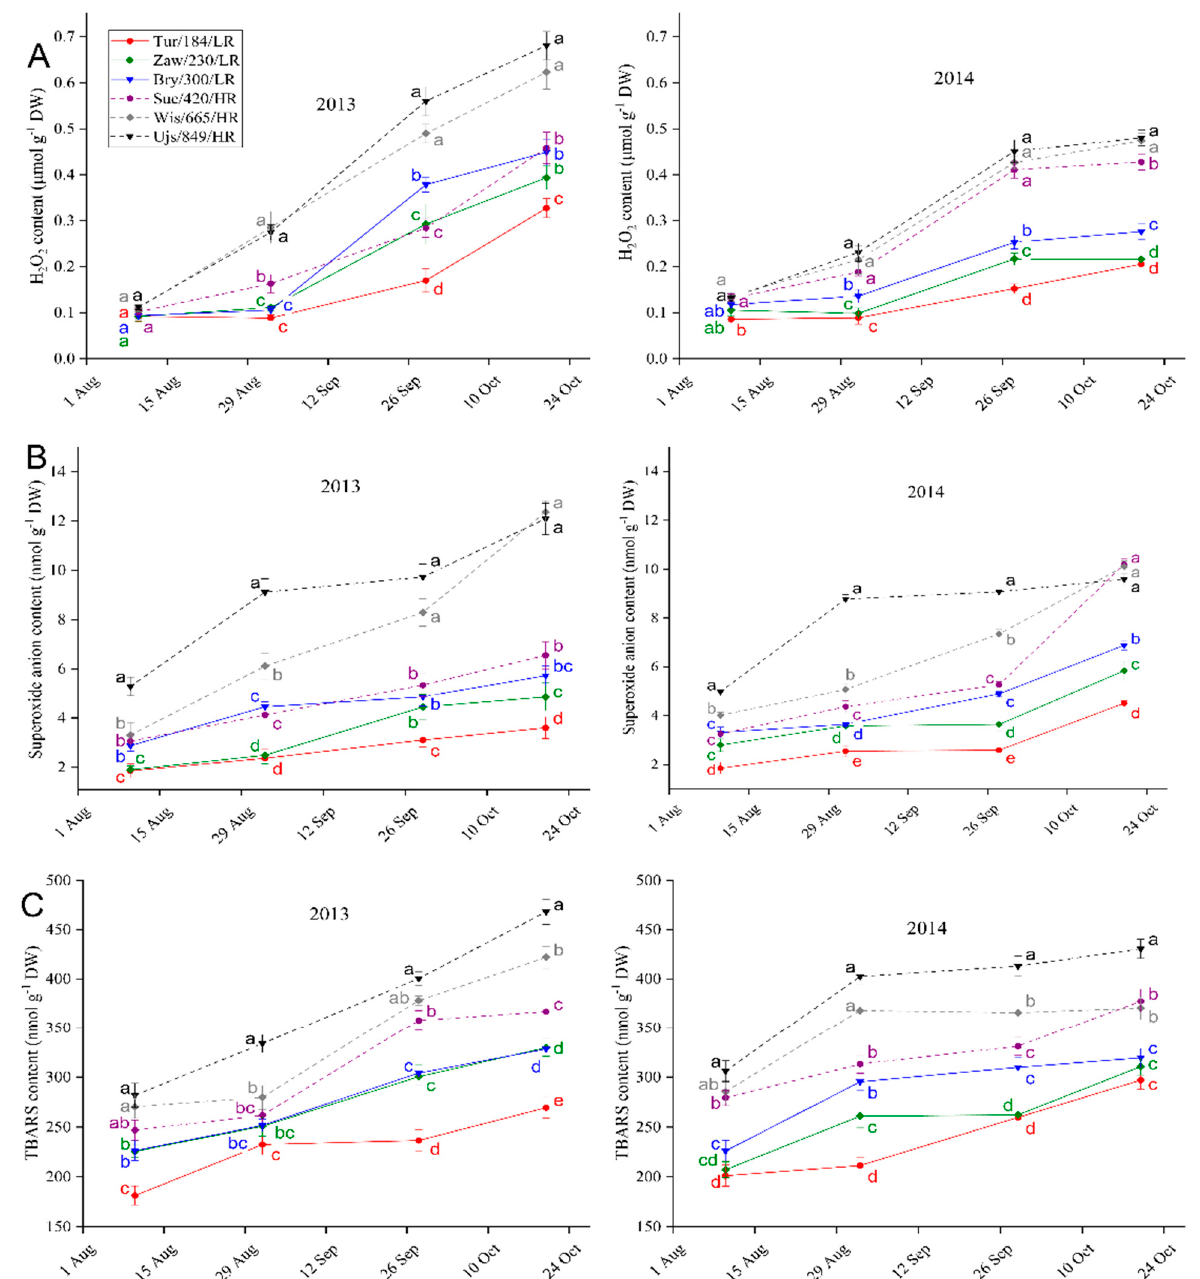
Figure 4. Changes in hydrogen peroxide ( A ), superoxide anion ( B ), and TBARS ( C ) content in the leaves from different provenances of beech trees ( Fagus sylvatica L.). Analyses were performed for provenances from high-altitude (dashed line) and low-altitude (solid line) regions in 2013 and 2014. Each point is the mean of 15 measurements (±SE). Means with different lowercase letters for each sampling date differ significantly at p < 0.05.